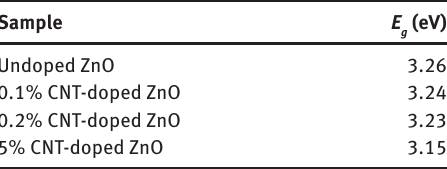
Table 2 Optical band gap values of the